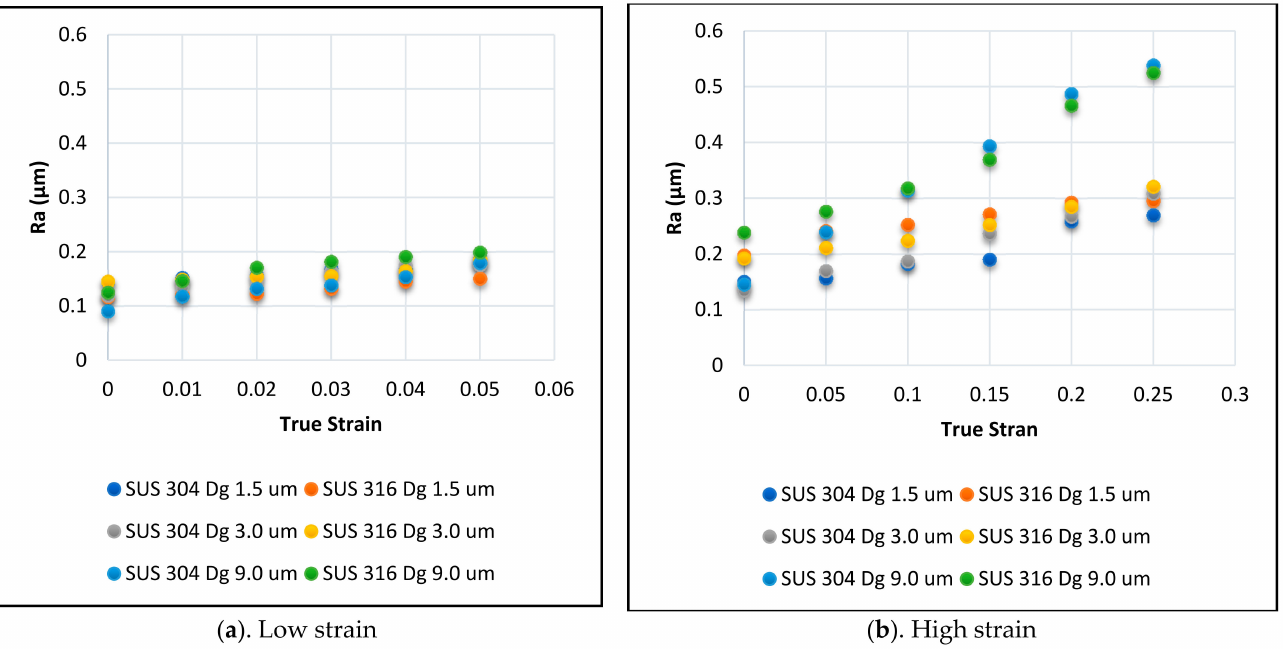
Figure 4. Surface roughening behavior in SUS 304 and SUS 316, low strain ( a ) and high strain ( b ). According to Figure 3a,b, Dg 1.3 µ m was SUS 316 thin foil without annealing, and Dg 0.5 µ m, Dg 1.0 µ m, Dg 1.5 µ m, Dg 3.0 µ m, Dg 9.0 µ m were SUS 304 thin foil